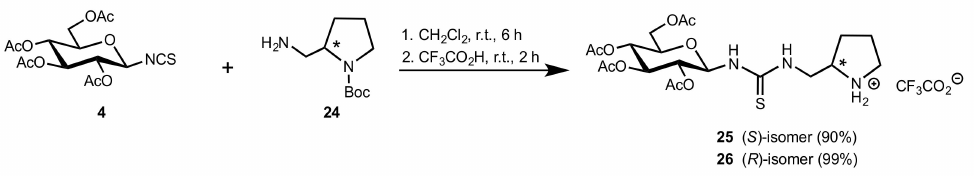
Scheme 7. The synthesis of organocatalysts 25 and 26 .